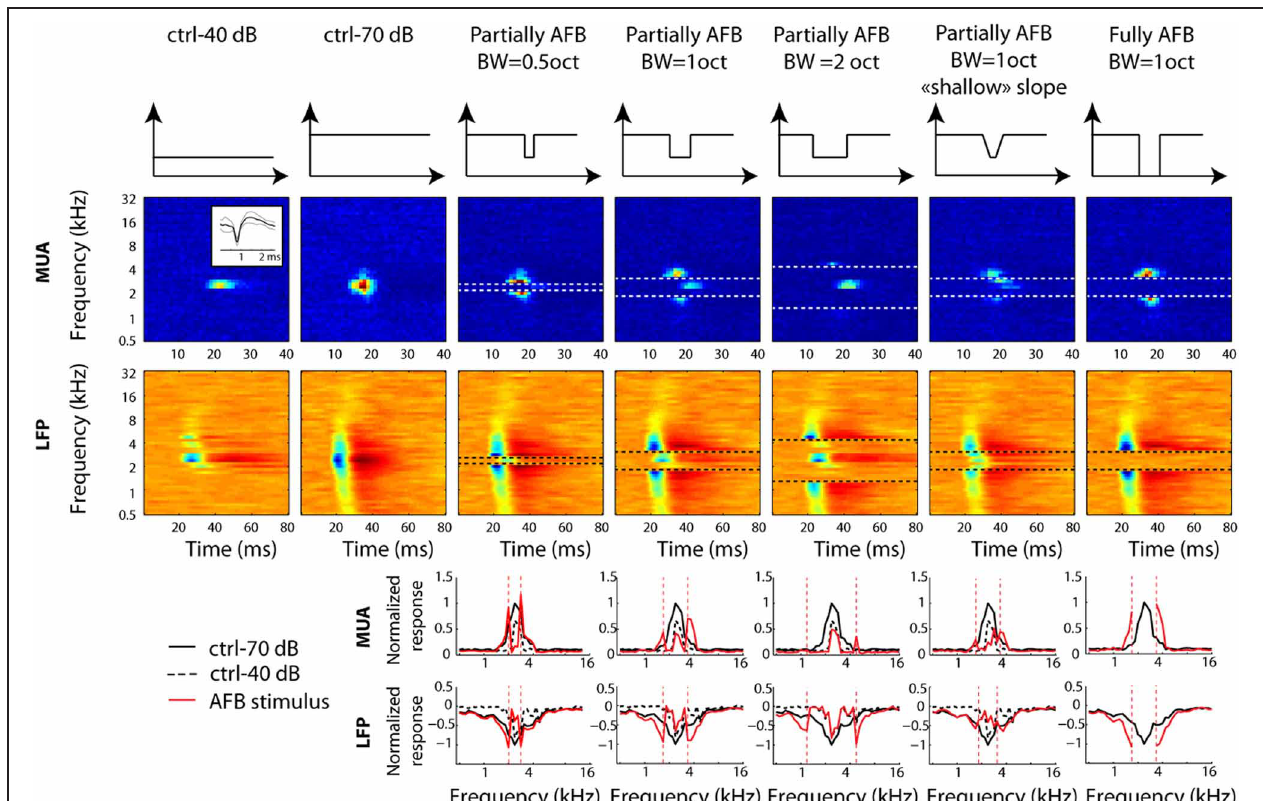
firing rate of MUA, or by taking the minimal amplitude of LFPs, in the 10–40ms time window, respectively. Vertical dotted lines represent the edge frequencies of the AFB. In order to permit direct comparison of neural responses between control and AFB conditions (red lines), the ctrl-70 (black lines) and ctrl-40 (dotted lines) conditions are added to each figure. Neural responses are greatly enhanced at the edges of the notch and decreased within the notch. The largest increase of responses is observed for the sharp contrast and the full-notch conditions (seventh